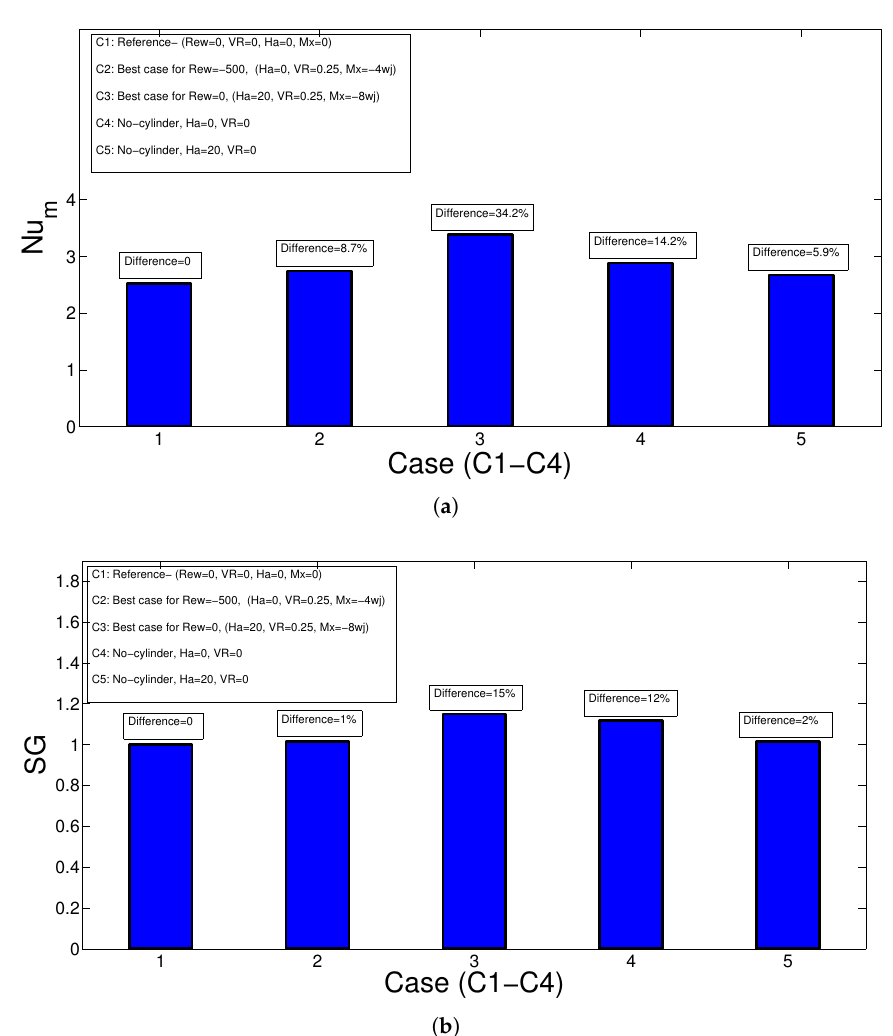
Figure 12. Comparison of best cases in terms of thermal performance ( a ) and EG ( b ) considering both rotating and non-rotating CC